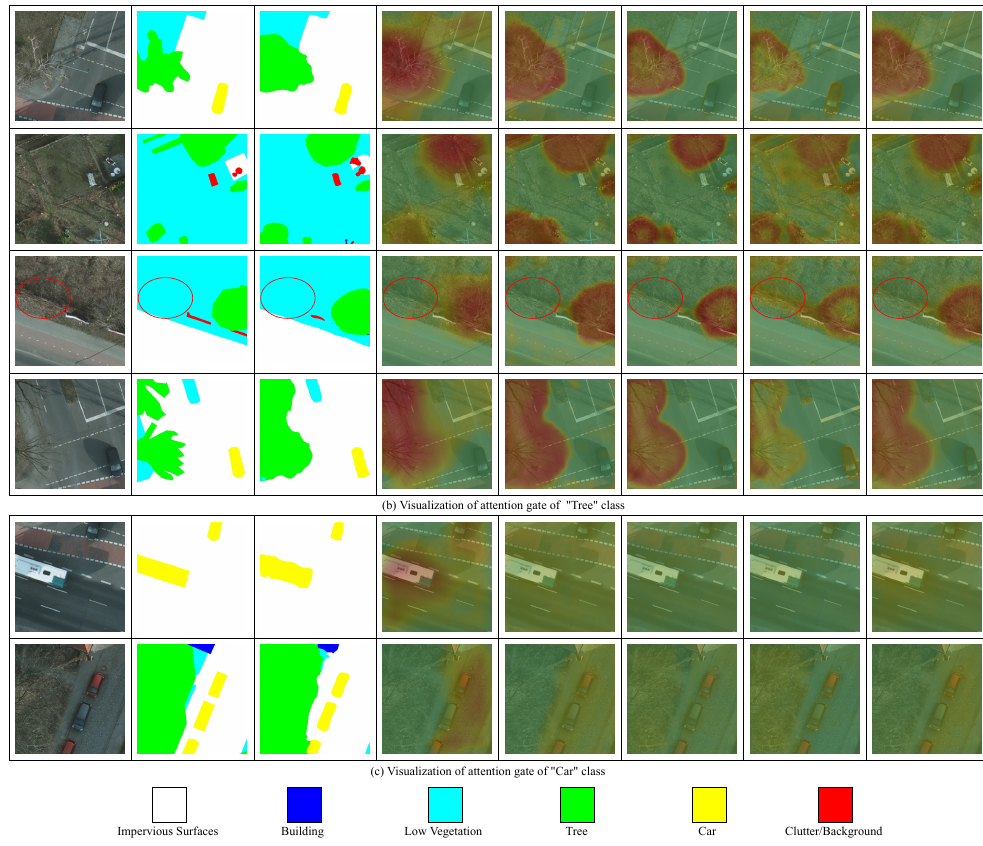
Figure 8. Visualization of the global attention gate for the Potsdam dataset generated by GAG using GMAUResNeXt_v2. Each heatmap corresponds to a specific class. GAG_1 denotes the global attention gate is generated by the GAG_1 shown in Figure 2. GAG_final denotes the final attention gate generated by the attention fusion module combining the information of the global attention gate of four